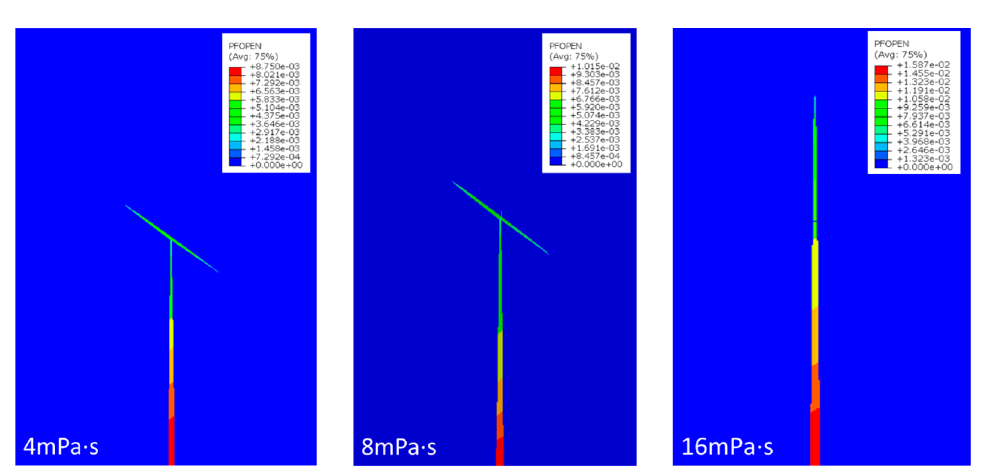
9 of 11 Figure 8. Crack geometry in different fracturing fluid injection rate.